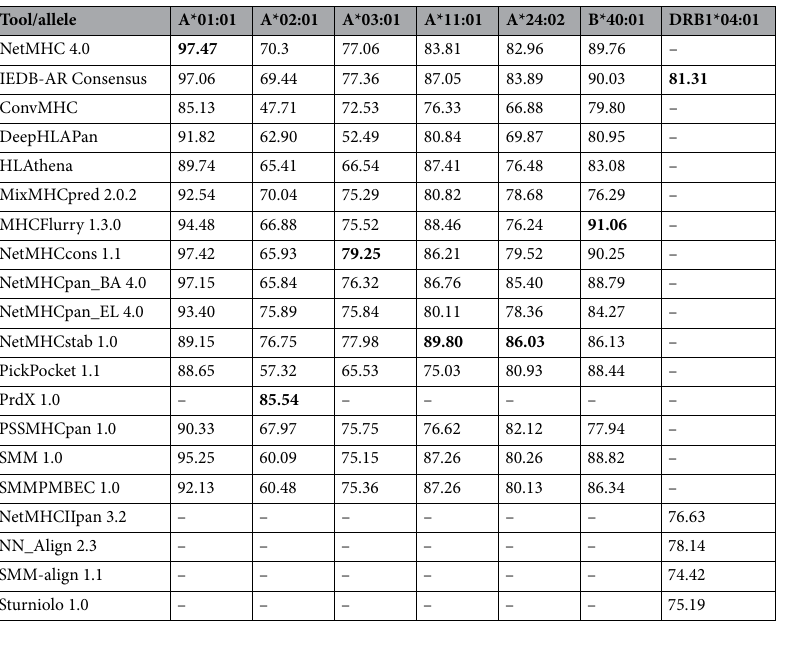
Table 2. AUC values for ROC curves from Fig. 1 for alleles with more than 10 stable complexes. First 6 six columns contain HLA class I, last column contains HLA class II. Only four tools were tested for HLA class II. PrdX 1.0 is only available for allele A*02:01. Highest value for each allele is marked in bold.